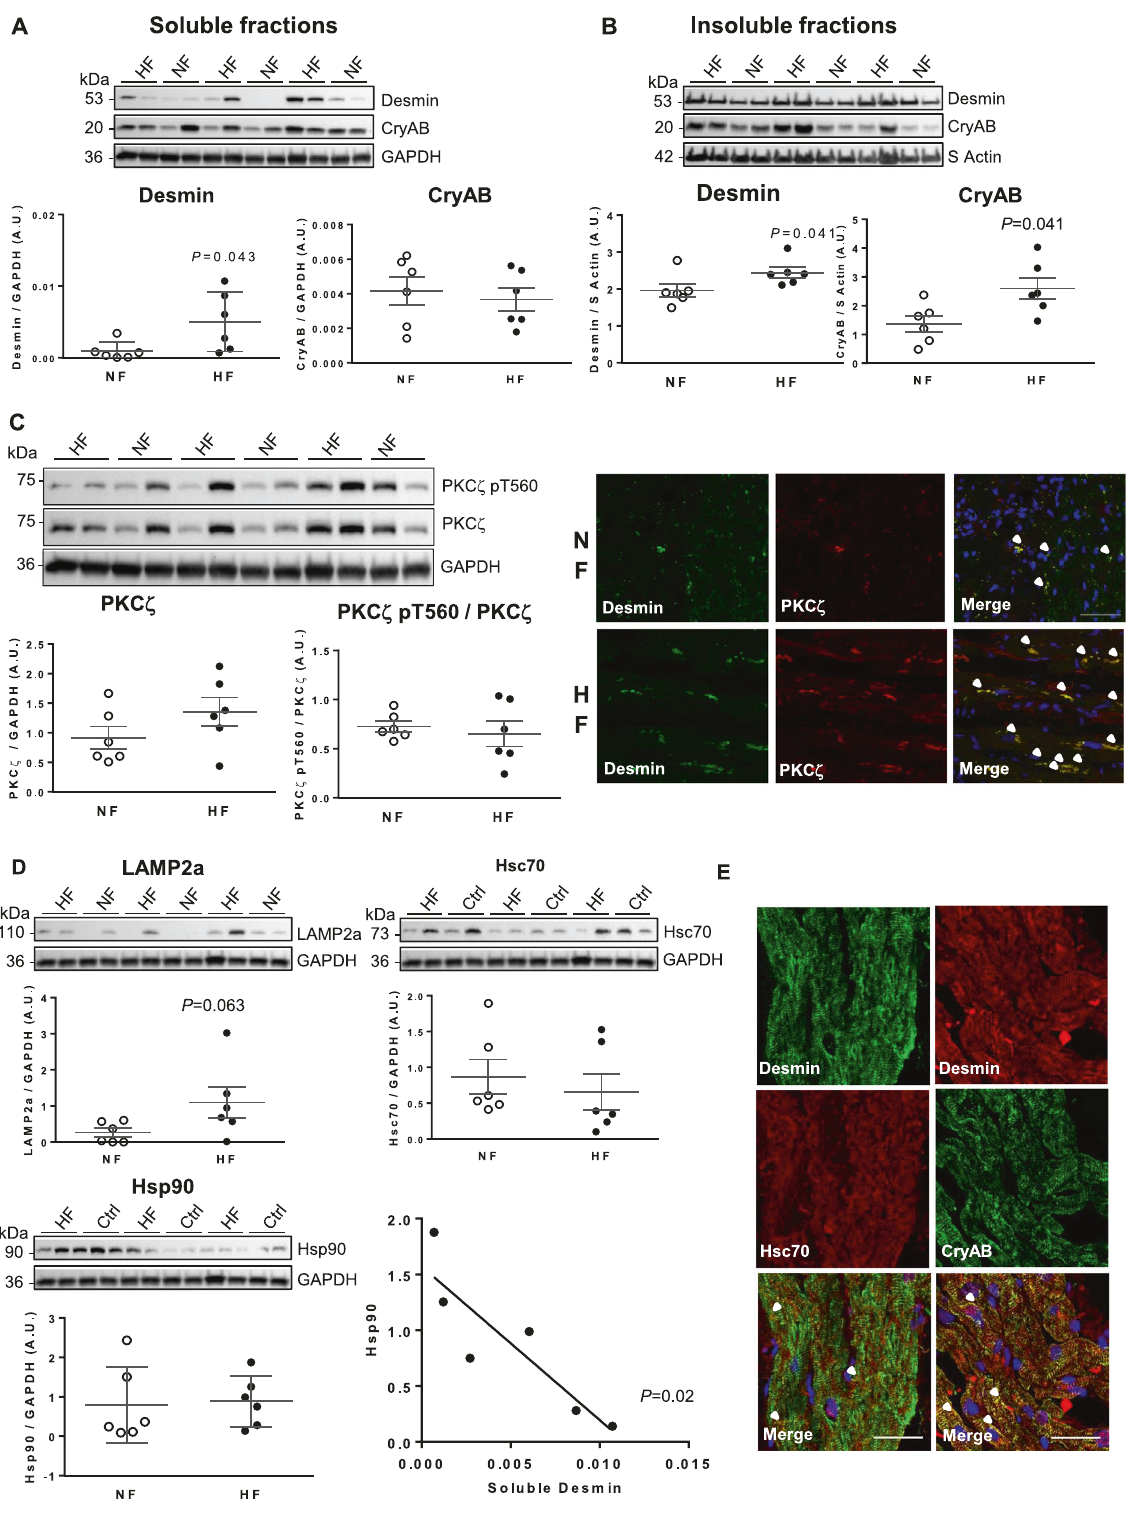
data are in agreement with publications showing cleaved form of desmin in cytoplasmic aggregates [34, 45]. Our data suggest that despite the ability of CMA to mediate clearance of desmin in vitro in cardiomyocytes, in the in vivo model of ischemic HF, CMA is unable to clear phosphorylated desmin which forms aggregates, mainly detected in the insoluble protein fraction, suggesting